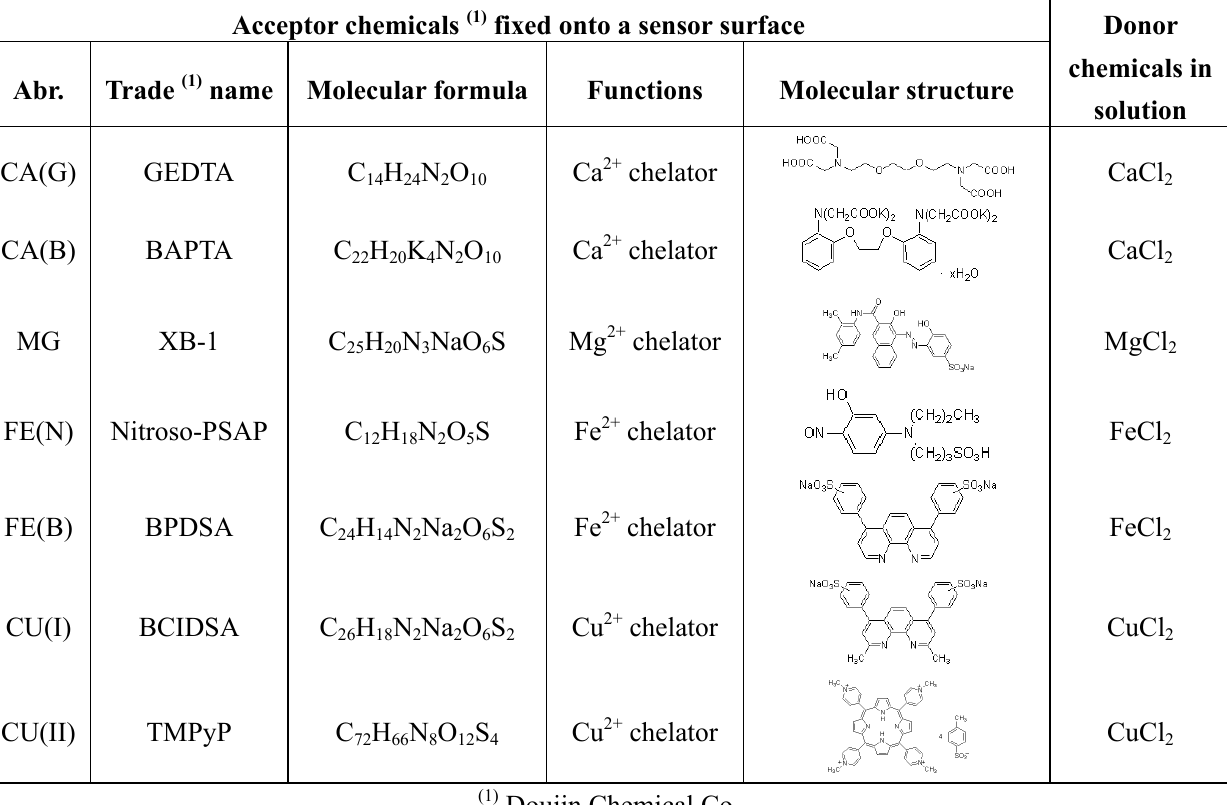
Table 1. Combination of donor- and